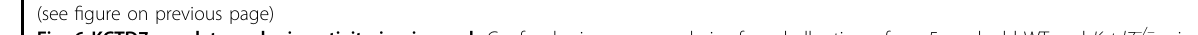
Fig. 6 KCTD7 regulates calpain activity in vivo. a , b Confocal microscopy analysis of cerebellar tissue from 5-week-old WT and Kctd7 – / – mice showing CAPNS1 co-localization with the lysosomal marker LAMP1 in Purkinje cells. Trace outline is used for line-scan (white dashed line) analysis of relative fl uorescence intensity of CAPNS1 and LAMP1 signals. Scale bar, 20 μ m. c – e Cerebellar tissues from 5-week-old WT and Kctd7 – / – mice were lysed in RIPA buffer and immunoblotted with the indicated antibodies, n = 4. f – l , Cerebellar tissues from 5-week-old WT and Kctd7 – / – mice were lysed in NP-40 lysis buffer and calpain 1 and CAPNS1 were immunoprecipitated and probed for interaction with α -spectrin by immunoblotting ( f – h ). Lysates from same tissue samples were also immunoblotted for α -spectrin ( f – i ) and p35 ( j – l ) to evaluate calpain-mediated cleavage, n = 4. Data